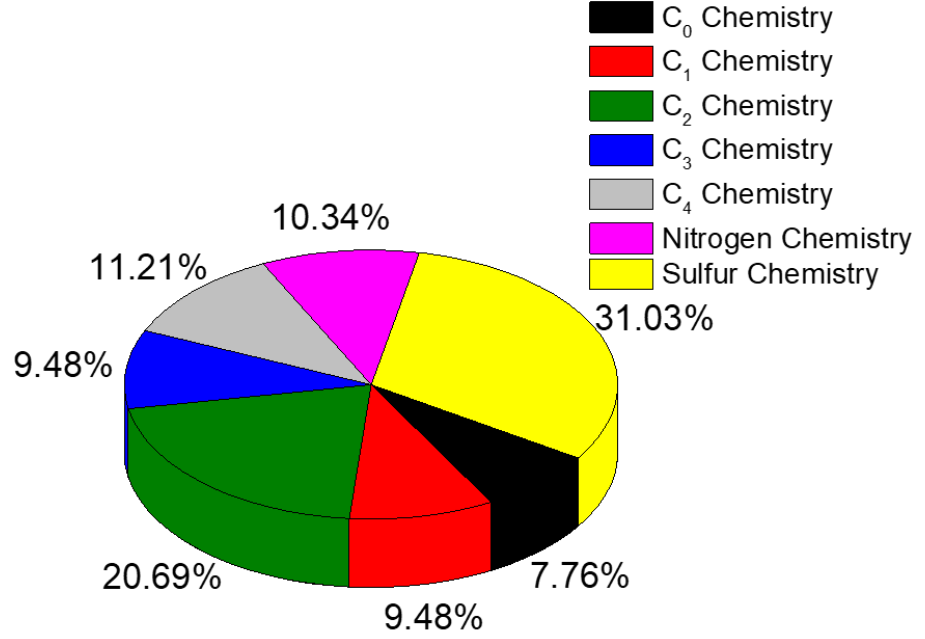
Figure 1. Composition of the kinetic library included in the detailed kinetic mechanism adopted in this work.